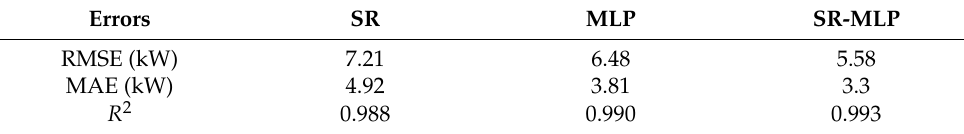
Table 2. Comparison of Score